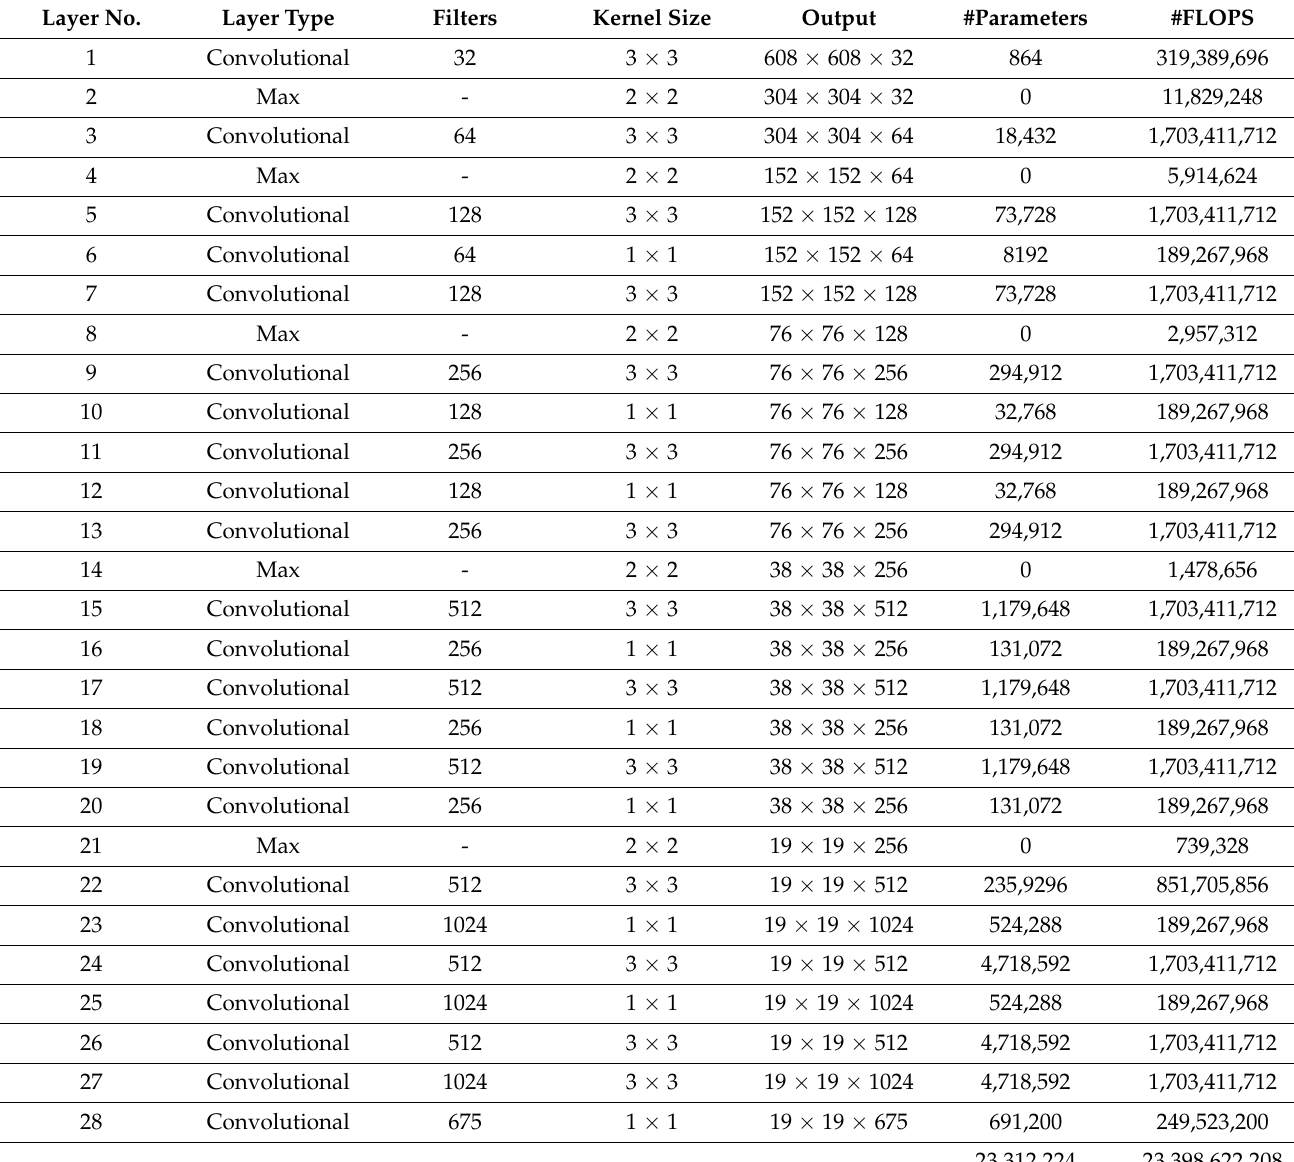
Table 5. Calculation of learnable parameters and FLOPS for the proposed model. Layer